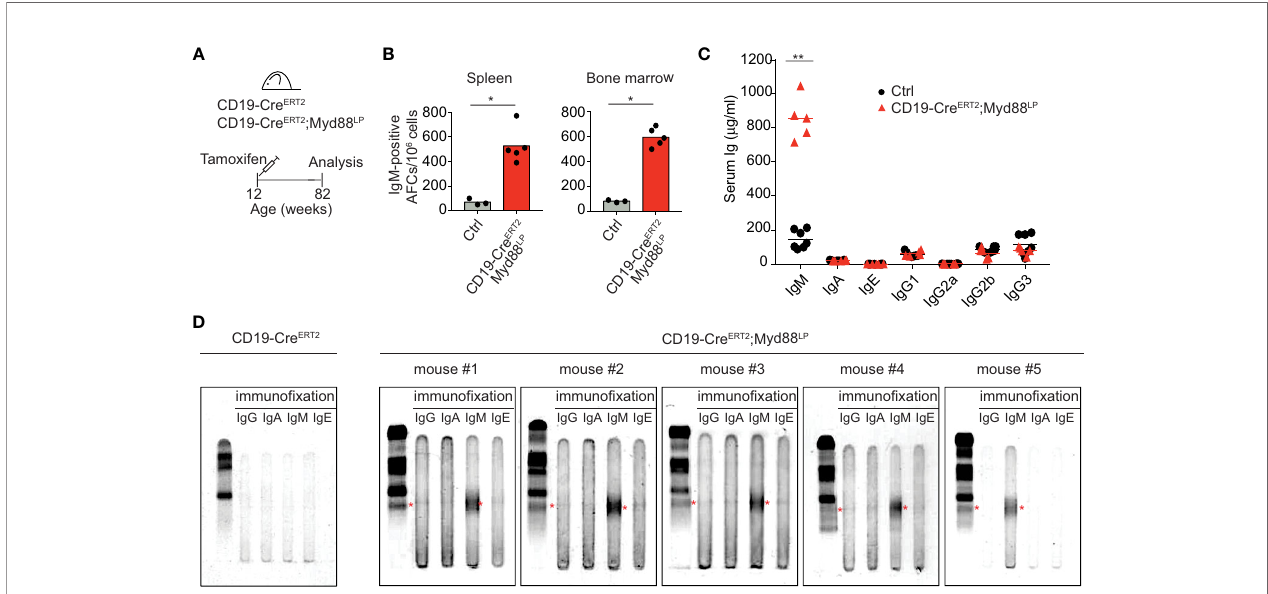
FIGURE 4 | Myd88 L252P -expression in a small number of B cells leads to serum IgM paraproteins (M-spikes). (A) CD19-Cre ERT2 ;Myd88 L252P animals were fed one time with tamoxifen and analyzed after 70 weeks. (B) ELISPOT analysis in spleen and bone marrow. IgM-secreting, antibody-forming cells are fi ve to six times elevated in CD19-Cre ERT2 ;Myd88 L252P mice. (C) ELISA measurement of immunoglobulin serum titers. Only IgM was elevated in CD19-Cre ERT2 ;Myd88 L252P mice. (B, C) Each symbol represents one mouse (n ≥ 3). *p ≤ 0.05, **p ≤ 0.01. (D) Serum protein electrophoresis and immuno fi xation of serum from fi ve CD19-Cre ERT2 ; Myd88 L252P mice. Each mouse showed a paraprotein band within the g -globulin fraction (red stars) that was positive for IgM. Mouse #4 had an additional paraprotein band that was negative for IgM. (See also Supplementary Figures 7 and 8